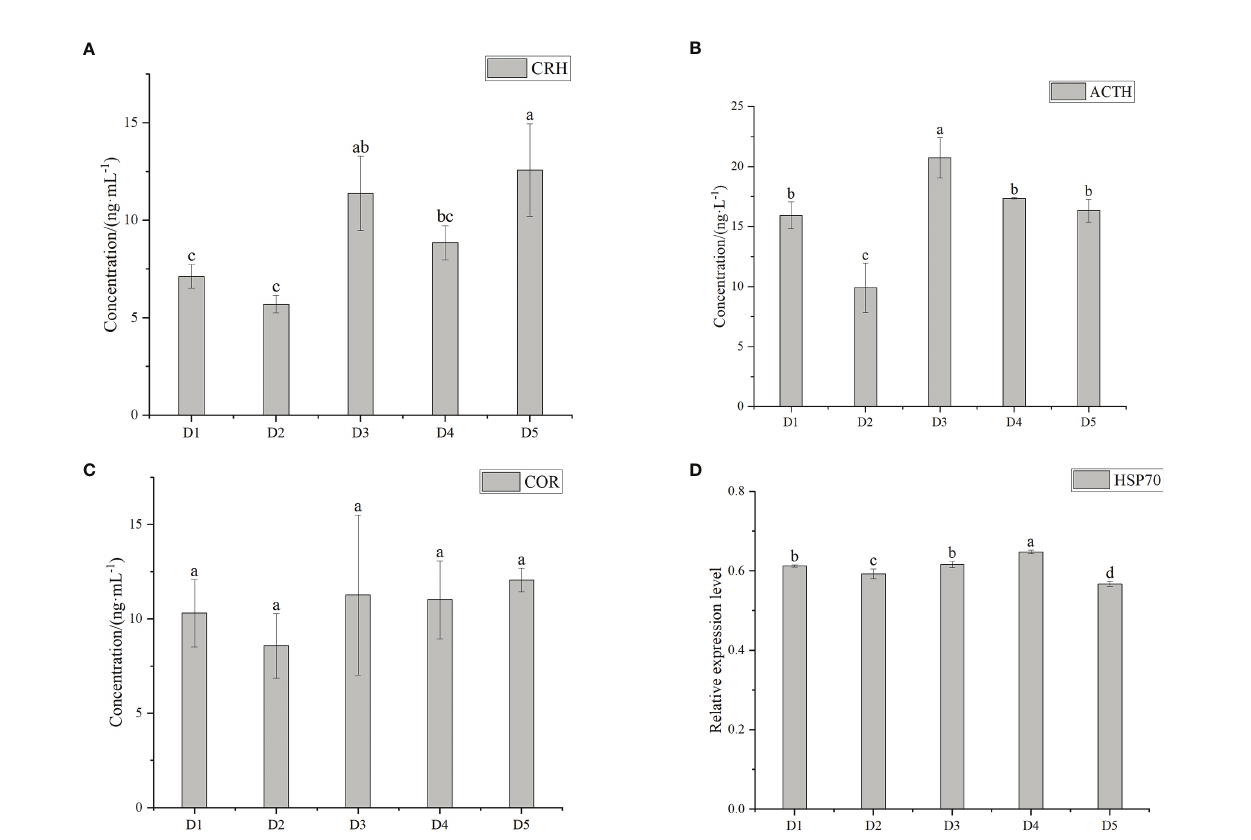
FIGURE 2 | The concentration of corticotropin releasing hormone (CRH) (A) , adrenocorticotrophic hormone (ACTH) (B) , cortisol (COR) (C) and the relative expression level of heat shock protein 70 (HSP70) (D) after transported at fi ve different densities. Different letters above bars indicate signi fi cant differences at the 0.05 level.